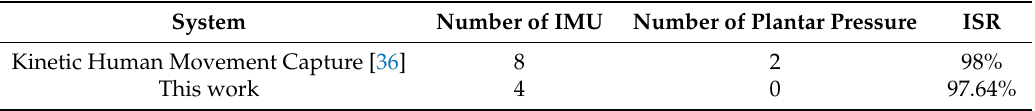
Table 4. Comparison with motion capture